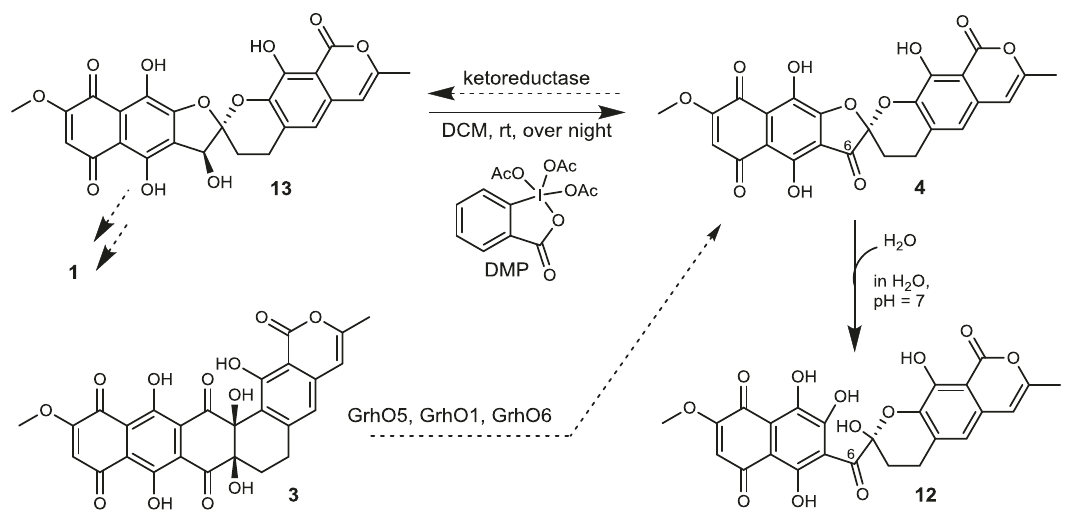
Fig. 4 Chemical preparation of 4 from 13 (isolated from S. albus KR7 10 ). Synthesized 4 converts into 12 in aqueous solution at neutral pH, as also